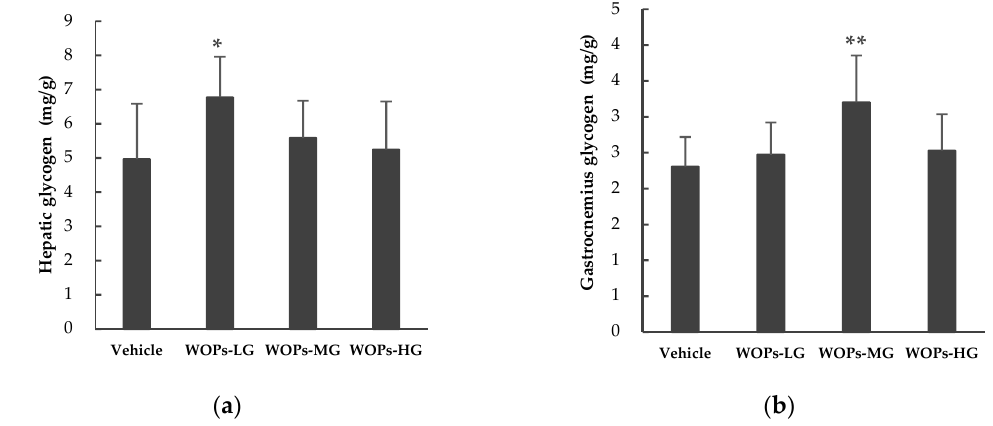
Figure 3. Effects of WOPs on liver glycogen ( a ) and gastrocnemius glycogen ( b ) in mice. Data are mean ± SD ( n = 10). * p < 0.05, ** p < 0.01 indicate significant difference compared with the vehicle group. WOPs-LG, 110 mg/kg of walnut oligopeptides group; WOPs-MG, 220 mg/kg of walnut oligopeptides group; WOPs-HG, 440 mg/kg of walnut oligopeptides